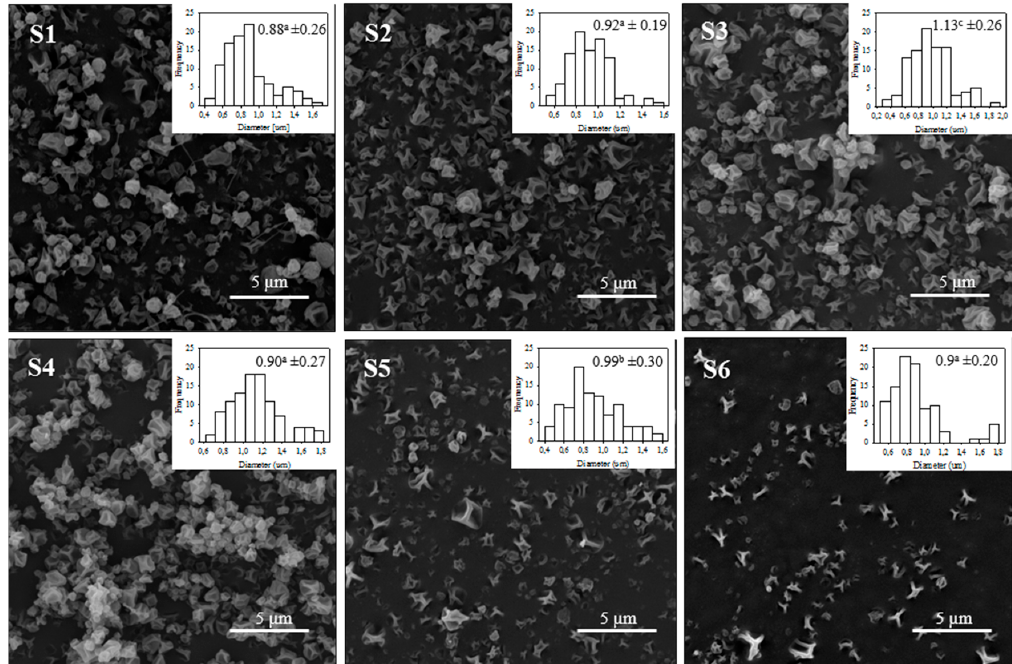
Figure 1. Histograms of electrosprayed zein–açaí structures with size distribution information as average and deviation ( μ m) and SEM micrographs of samples: S1, S2 and S3) 10 cm height and flow rates 0.3, 0.4, and 0.5 mL h -1 , respectively; and S4, S5, and S6) 12 cm height and flow rate 0.3, 0.4, and 0.5 mL h -1 , respectively. Values a, b, and c indicate significant differences between the samples, determined through a one-way analysis of variance (ANOVA) ( p < 0.05). SD corresponds to the standard deviation.